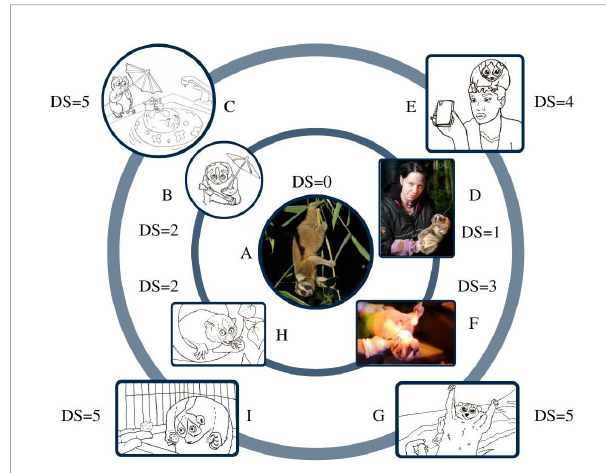
FIGURE 1 Examples of levels of decontextualization- copyrighted images that we did not have the rights to are illustrated. Each image is shown with a corresponding decontextualization score (DS) ranging from zero, indicating no elements of decontextualization to fi ve, indicating the presence of all elements of decontextualization. (A) Represents an ecologically accurate image of a slow loris. (B) The inner ring shows a slightly decontextualized image for a conservation campaign logo. (C) The slow loris from an animated television show portrayed as a house pet represents the furthest level of decontextualization. (D) A wild slow loris is captured in a natural setting for a study and is pictured with a researcher (K. A. I. Nekaris). (E) An illustration of the pop singer Rihanna with a slow loris representing the viral photo of her with a photo prop loris. (F) A slow loris being handled for research showing a stress response of clinging. (G) A pet loris from a viral ‘ tickle ’ video in a defence pose. (H) A slow loris at a zoo eating a grasshopper with some vegetation around. (I) A slow loris from a viral ‘ rice ball ’ video holding unnatural